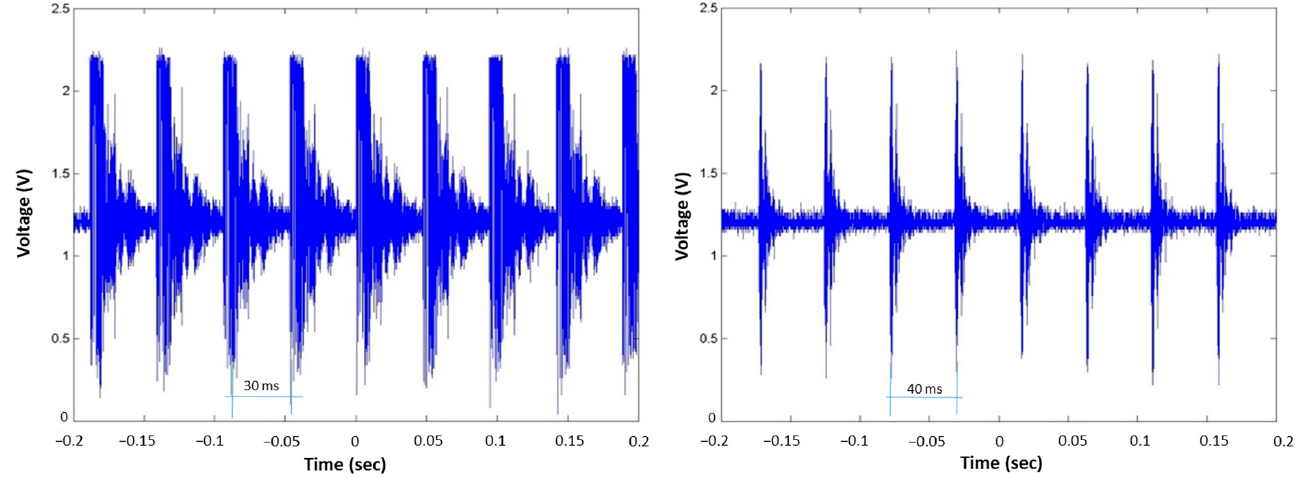
Figure 11. Received guided wave pulses amplified and filtered; ( left ), dry steel tube, TSBP of 30 ms; ( right ), steel tube flooded at 10%, TSBP of 40 ms.